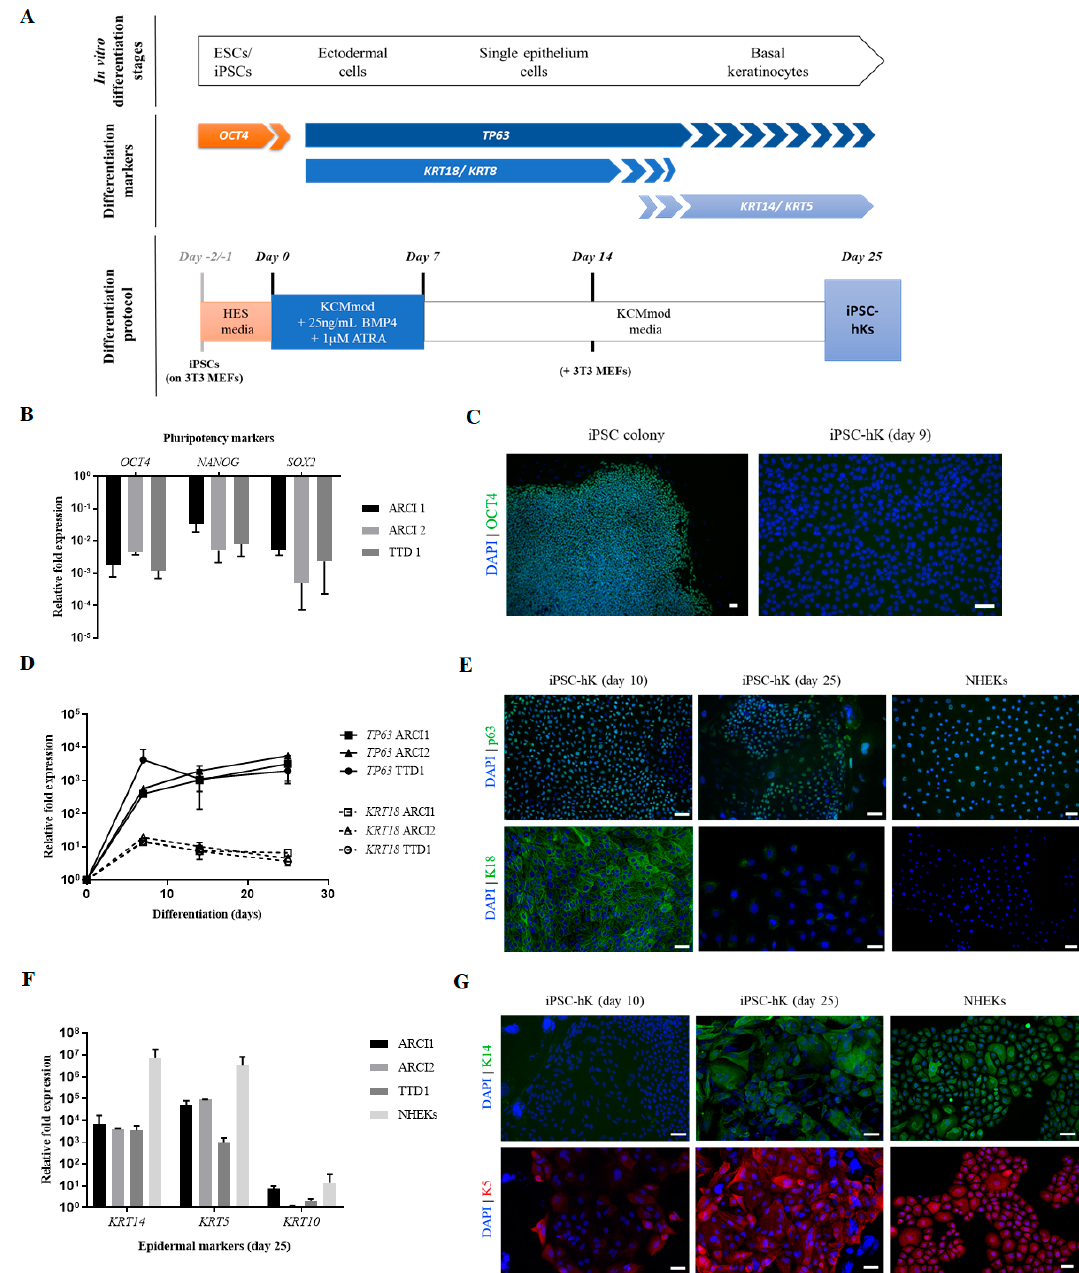
Figure 3. In vitro hiPSC differentiation into hiPSC-derived keratinocytes mimics epidermal morphogenesis. ( A ) Schematic representation of differentiation process and comparison with key stages and markers of epidermal formation. ( B ) Relative expression of pluripotency markers OCT4 , NANOG and SOX2 after 14 days of differentiation (minimum n = 2). ( C ) OCT4 protein was undetected by immunocytochemistry approx. 9 days post-differentiation compared to positive control (undifferentiated hiPSC colony). Scale bar 50 µ m. ( D ) Relative expression of early ectodermal markers TP63 and KRT18 throughout the differentiation process; KRT18 levels at day 25 are significantly reduced compared to day 7 ( p < 0.001) (minimum n = 2). ( E ) Representative immunocytochemistry of differentiating hiPSC-bKs at days 10 and day 25 showing expression of p63 and keratin 18 (K18). Normal primary keratinocytes (NHEKs) were used as positive controls. Scale bar 50 µ m. ( F ) Relative expression of basal keratinocytes-specific KRT14 and KRT5 in hiPSC-bKs after 25 days of differentiation (minimum n = 2). ( G ) Representative immunocytochemistry of hiPSC-bKs after 10 and 25 days and NHEKs, showing expression of basal keratinocyte-specific keratins 14 (K14) and 5 (K5). Scale bar 50 µ